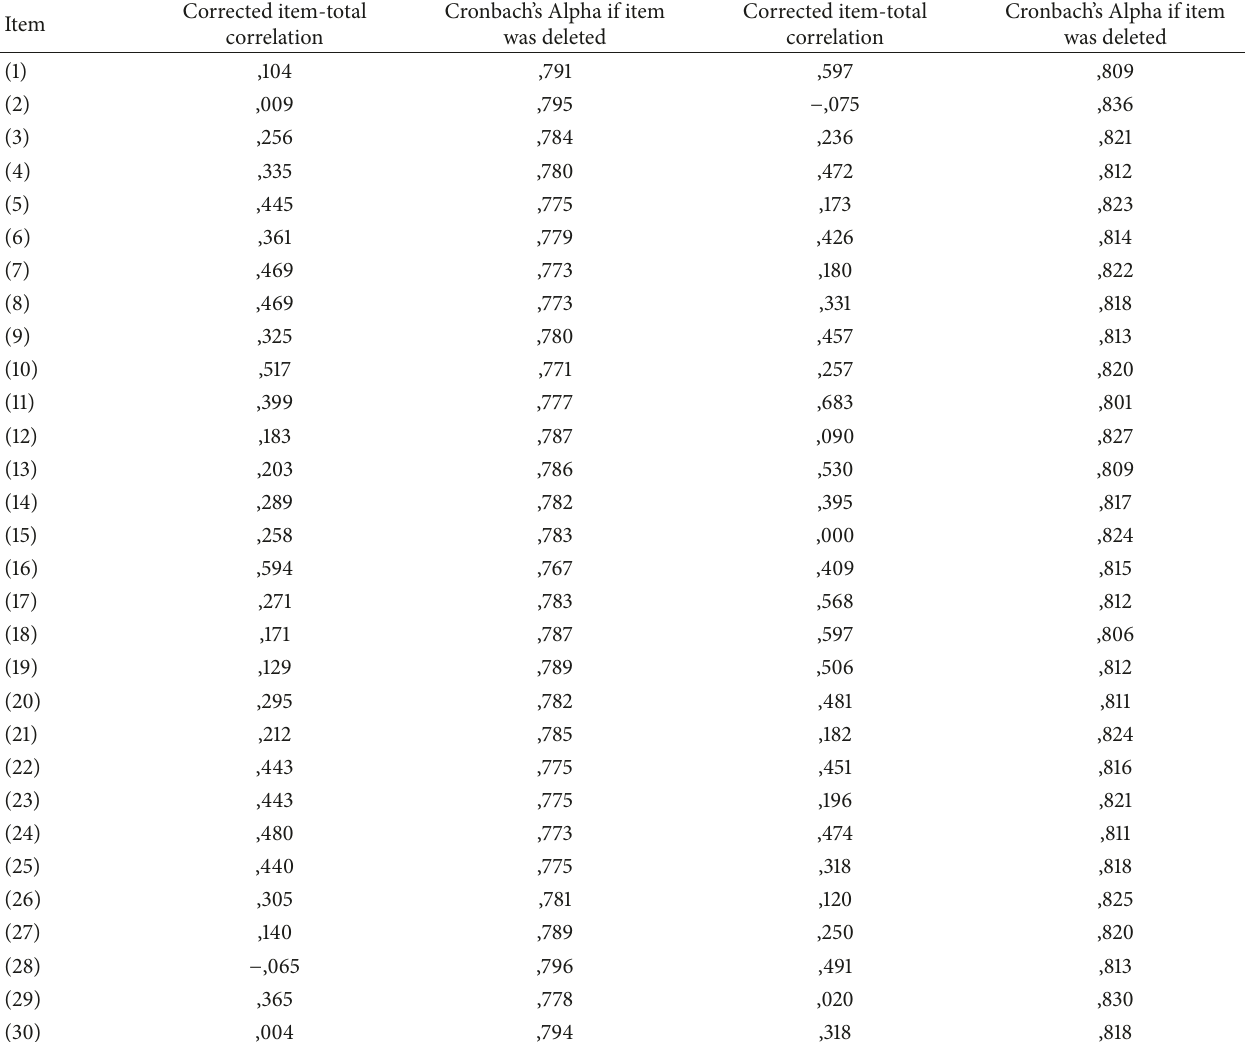
Table 3: Item X tot-item